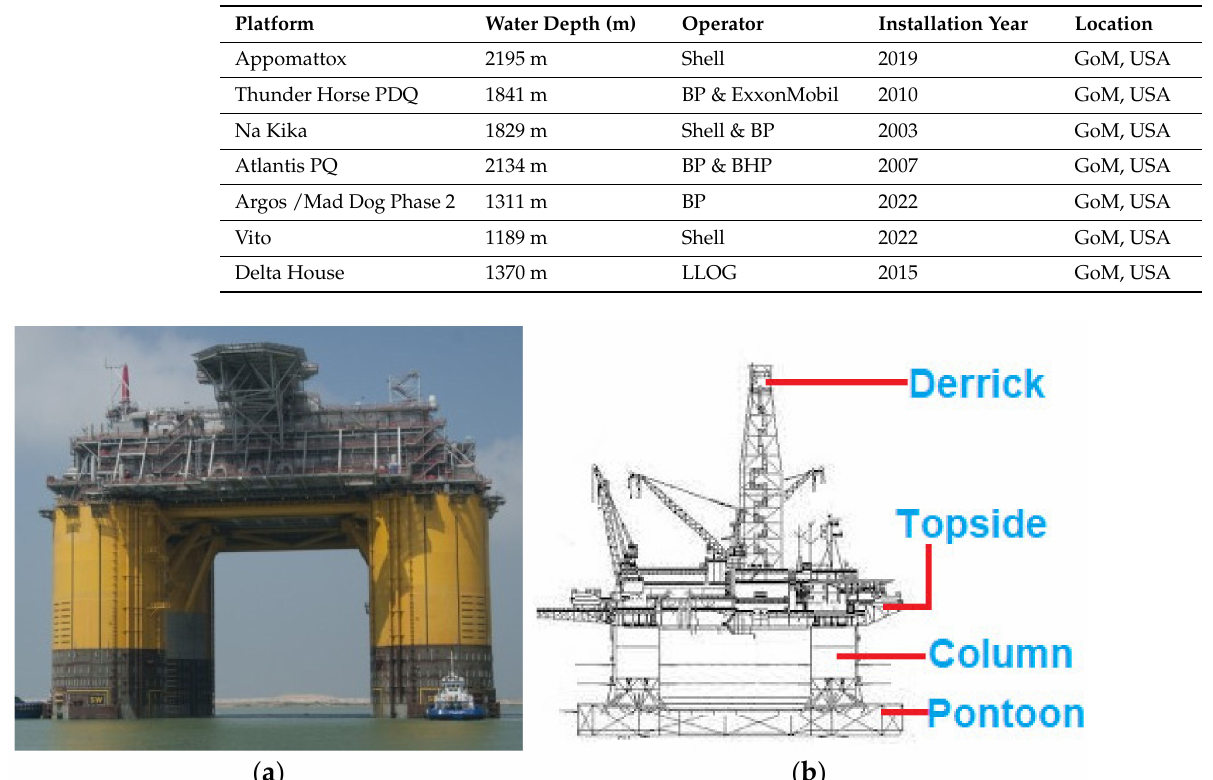
Table 5. List of some semisubmersible platforms for deep water drilling and production.